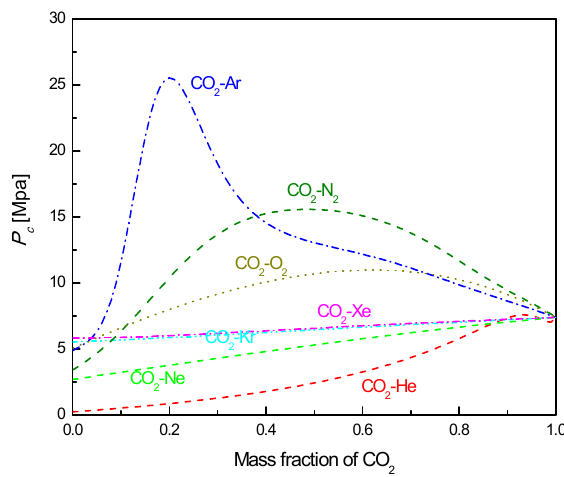
ff erent mass fractions of CO